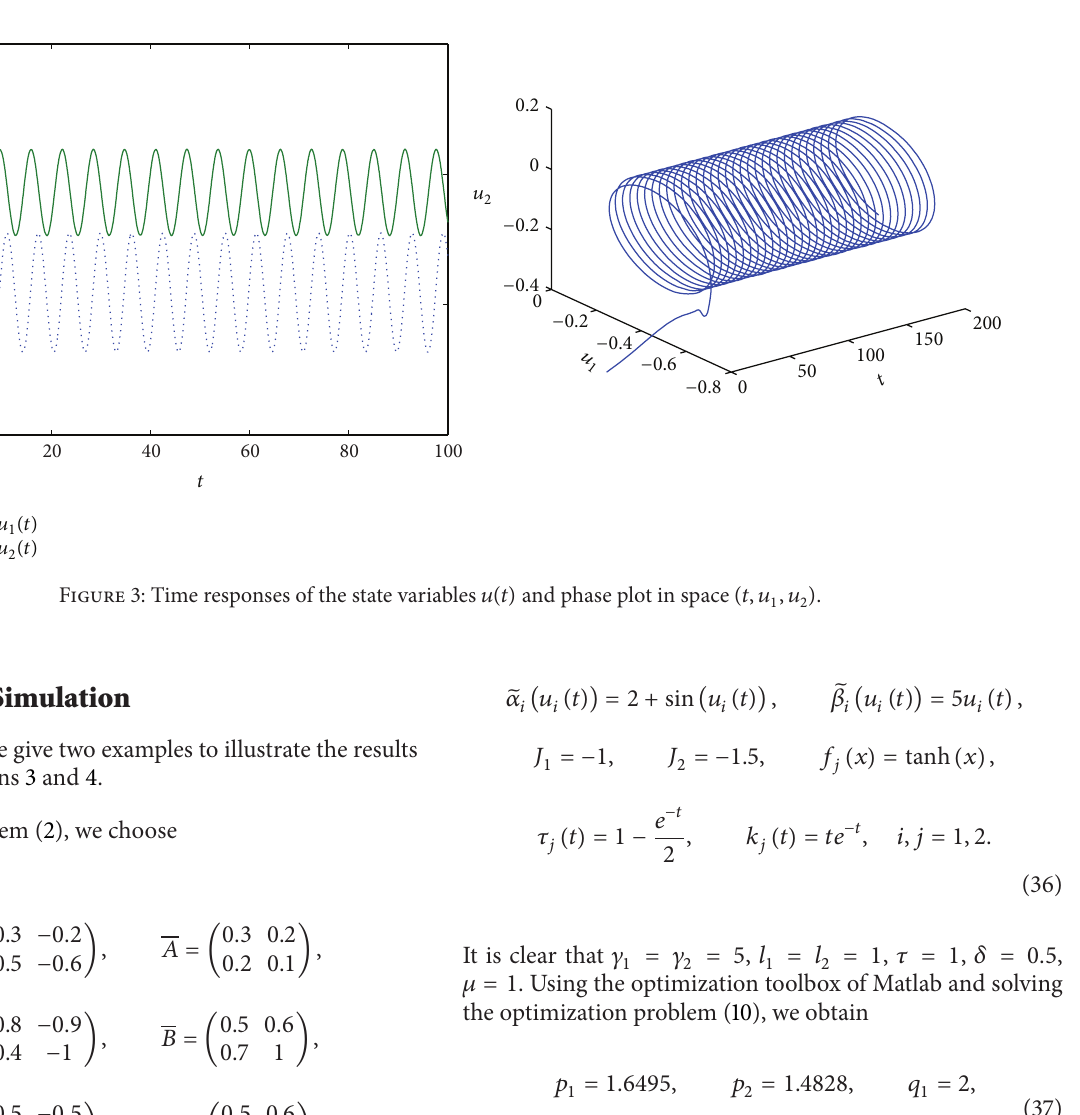
Figure 2: Bifurcation diagrams of system (2), and these show the effect of the parameter 𝛽 on the dynamic behavior.